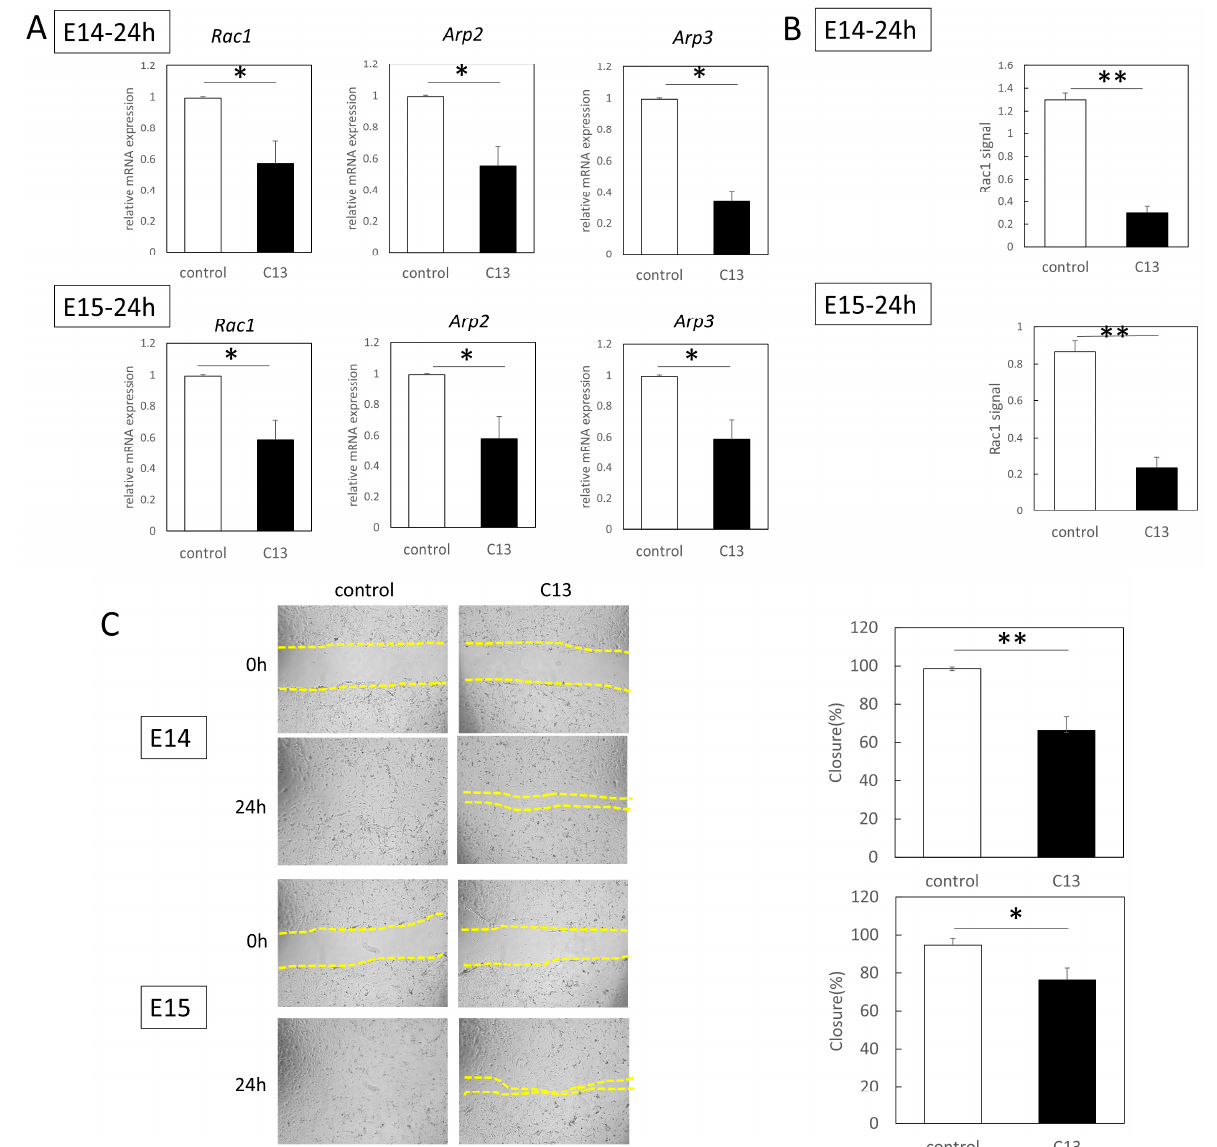
Figure 3. Suppression of Rac1 signaling and cell migration by C13 in fetal mouse epidermis. ( A ) Comparison of Rac1 signaling-related gene expression at 24 h post-injury. Gene expression levels were normalized using ACTB as an endogenous control. ( B ) Comparison of Rac1 signals at 24 h post-injury. Absorbance was read at 490 nm and the background was subtracted for comparison. ( C ) Migration assay of E14 and E15 mouse epidermal cells. The histogram on the right shows a comparison of the quantitative analysis of the scratch area. Migration is significantly inhibited in the C13 treatment group. * p < 0.05, and ** p < 0.01.